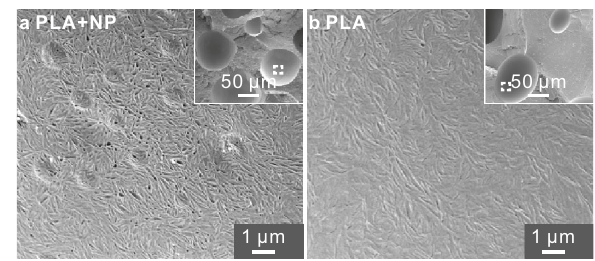
Fig. 4 SEM images of PLA fracture surface with and without nanoparticles. a PLA with 1.3 wt.% of 200nm silica NPs — zoom-in of fracture surface inside the spherical hole left by a detached spherulite (marked square in the wider-area inset). Holes left by individual nanoparticles and some of their clusters are seen, as well as numerous gaps between packets of lamellar crystals created by the intercalated NPs. Note that if the NPs were evenly distributed throughout the sample volume, they would have occupied only 0.7 % of the surface. b The same for PLA without NPs for comparison; the surface is markedly smoother.